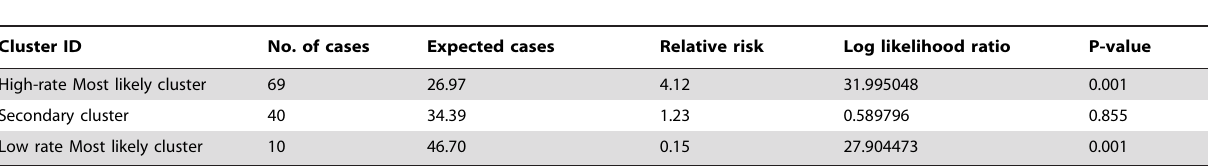
Table 1. Purely spatial clusters with significant higher and lower rates of TB in Dabat, Ethiopia, 2012.